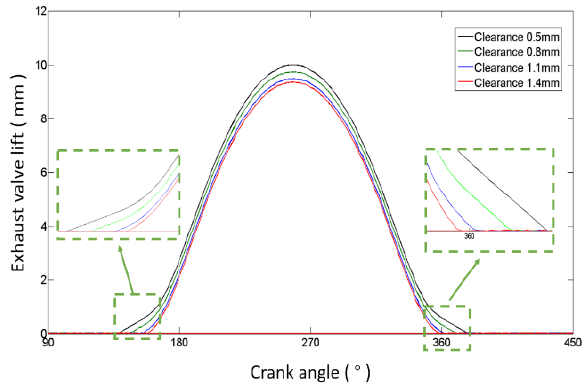
Figure 5. Valve lift of different clearances.